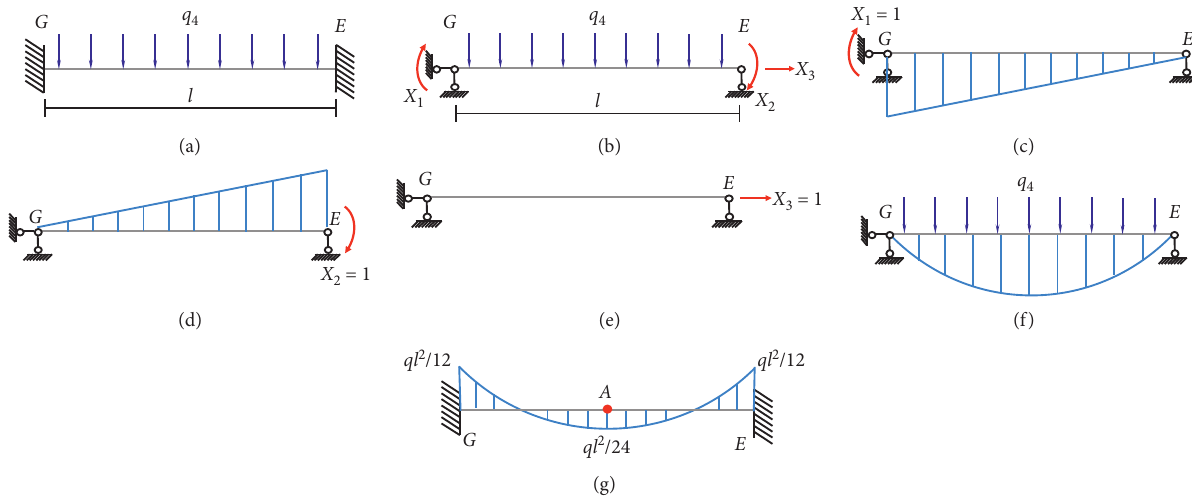
Figure 8: Stress analysis of statically indeterminate structure EG under uniformly distributed load. (a) Original structure. (b) Basic system. (c) Bending moment diagram M . (d) Bending moment diagram M . (e) Bending moment diagram M . (f) Bending moment diagram M P . 1 2 3 (g) Final bending moment diagram M